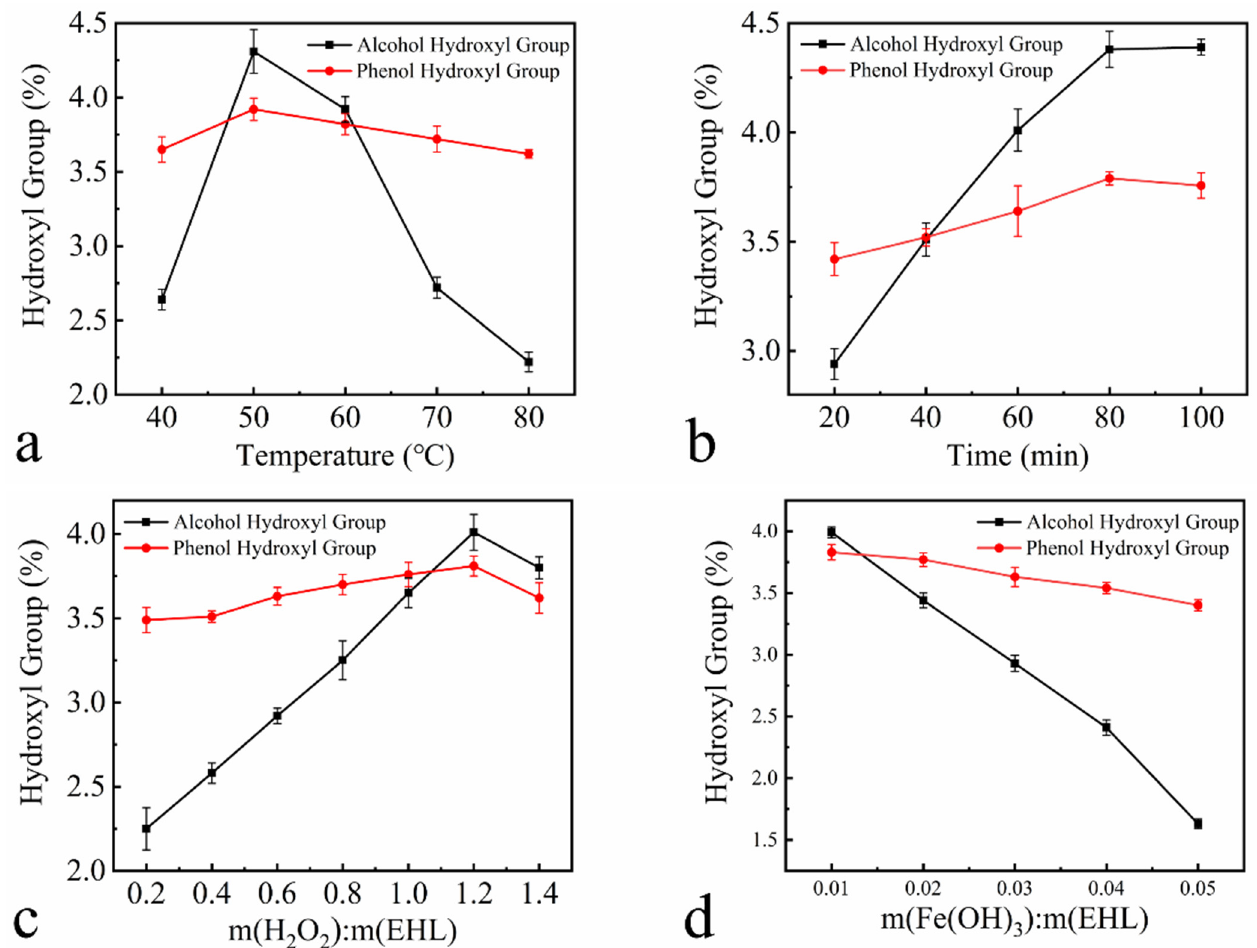
Figure 2. Molecular weight distribution curves of EHL and HEHL samples.